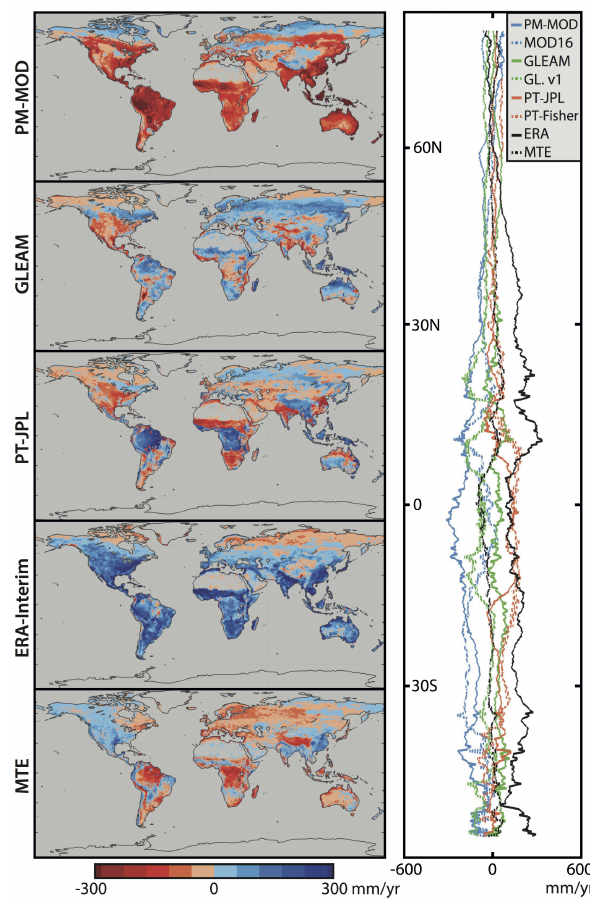
Figure 3. Long-term anomalies of evaporation, as in Fig. 2 but based on the anomalies for each product calculated as the mean of each particular product (i.e. the maps in Fig. 2) minus the inter- product ensemble mean (considering the ensemble of five models). Grey areas over the continents correspond to regions where MTE displays no estimates of